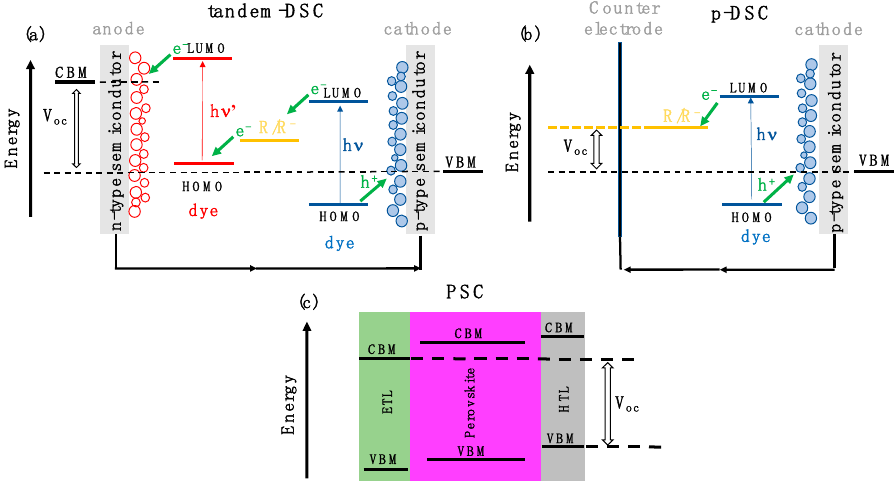
Figure 1. Energy levels alignment required for efficiently working p-type DSC ( a ), tandem-DSC ( b ) and PSC ( c ).